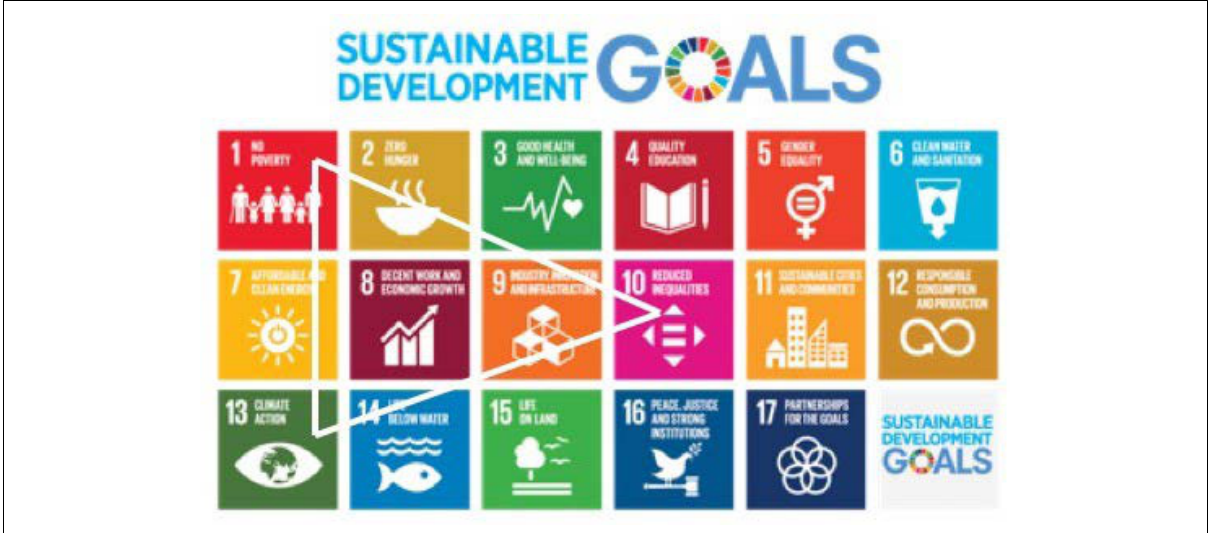
figure 3: Sustainable development goals on poverty, inequality and climate change; links between goals